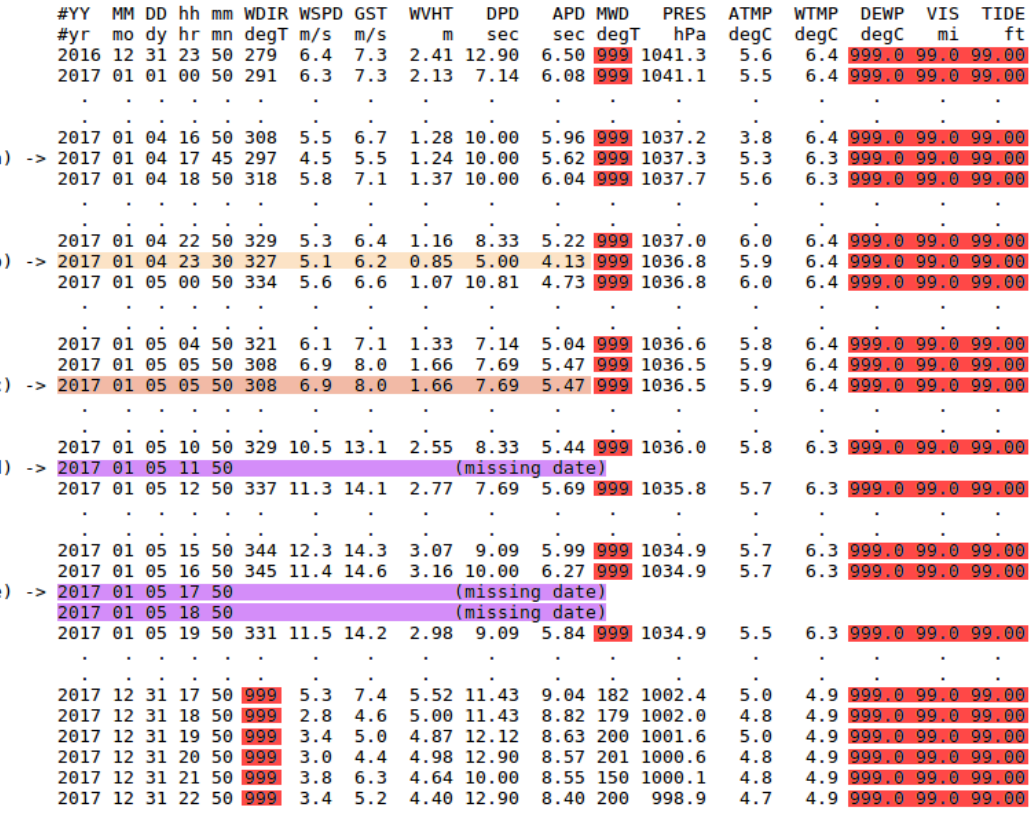
Figure A1. A fragment of an annual text file with different missing value examples.